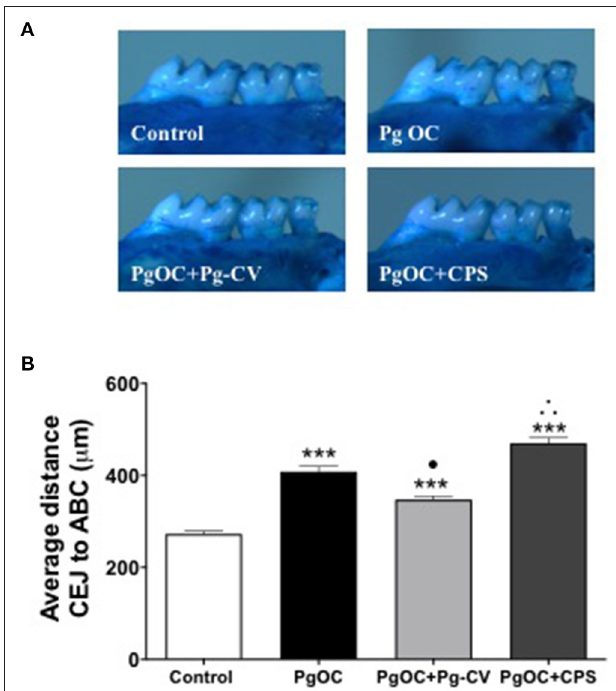
FIGURE 3 | Pg-CV vaccination protects animals from subsequent oral infection-elicited bone loss. (A) Representative images of an untreated group (Control), P. gingivalis oral challenge (Pg OC), P. gingivalis oral challenge + immunized with Pg-CV (PgOC + Pg-CV) and P. gingivalis oral challenge + immunized with P. gingivalis CPS + (PgOC + CPS). (B) Oral bone levels from experimental groups. Mean distance from the alveolar bone crest (ABC) to cementum enamel junction (CEJ) was measured at 14 landmark sites (7 on each hemimaxilla) per animal ( n = 10 mice/group), and measurement data were pooled to achieve group-level mean and SEM. *** P < 0.001 compared with Control, • P < 0.05 vs. Pg OC (decrease), ∴ P < 0.05 vs. Pg OC (increase) by ANOVA with Tukey